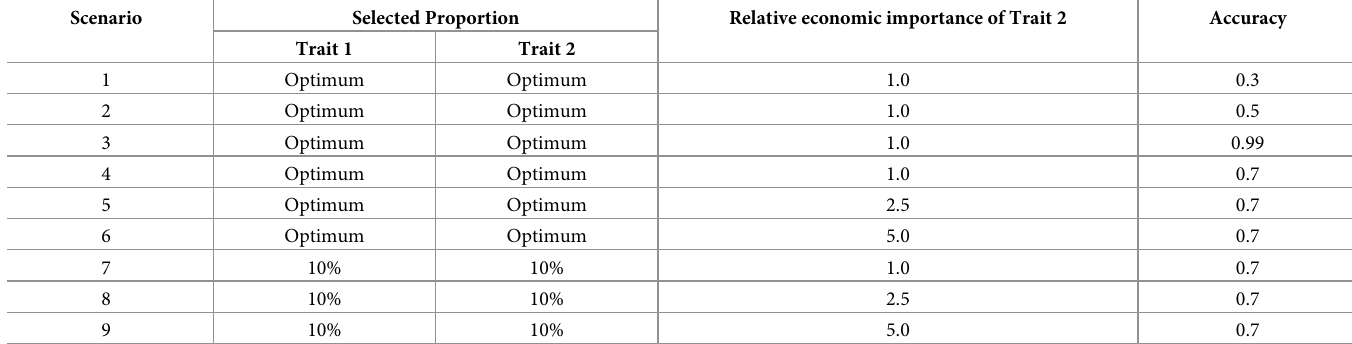
Table 1. Summary of parameters simulated in all comparison scenarios of recurrent selection breeding programs using either independent culling or selection index with two traits.